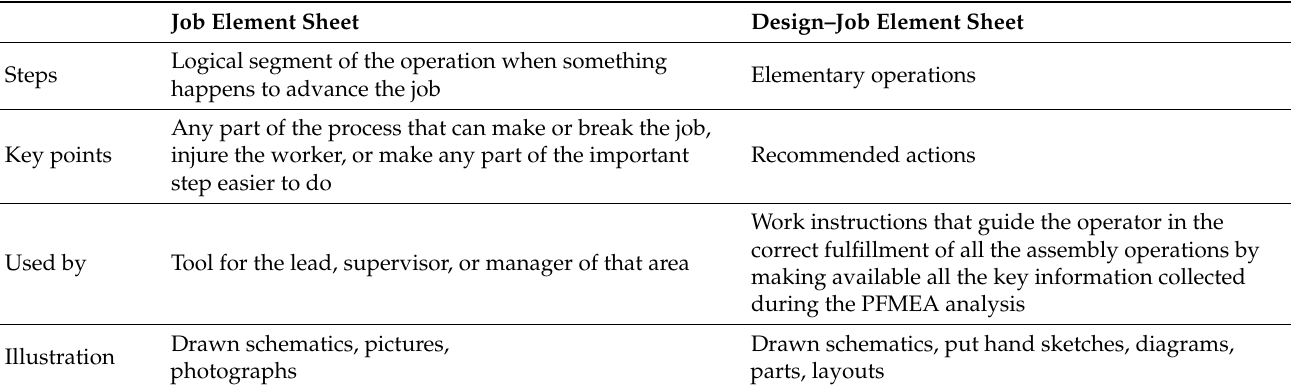
Table 3. Summary comparison between job element sheets (JESs) and